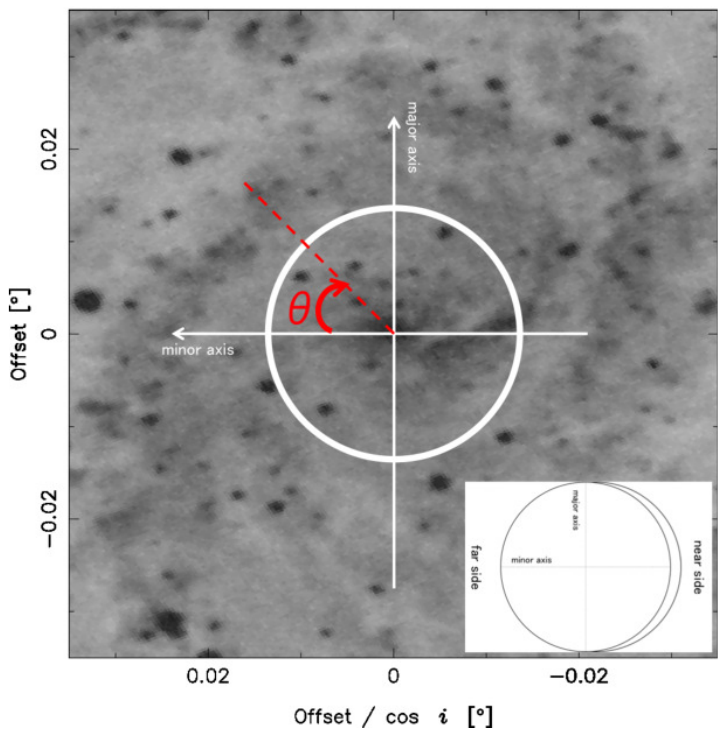
Figure 5. Definition of azimuthal angle in Figure 6. The background image is the same as the right panel of Figure 4. The azimuthal angle increases clockwise from the far end of the minor axis. The radius of the white circle is 1.36 kpc from the center. Right hand side of the disk is near to us.